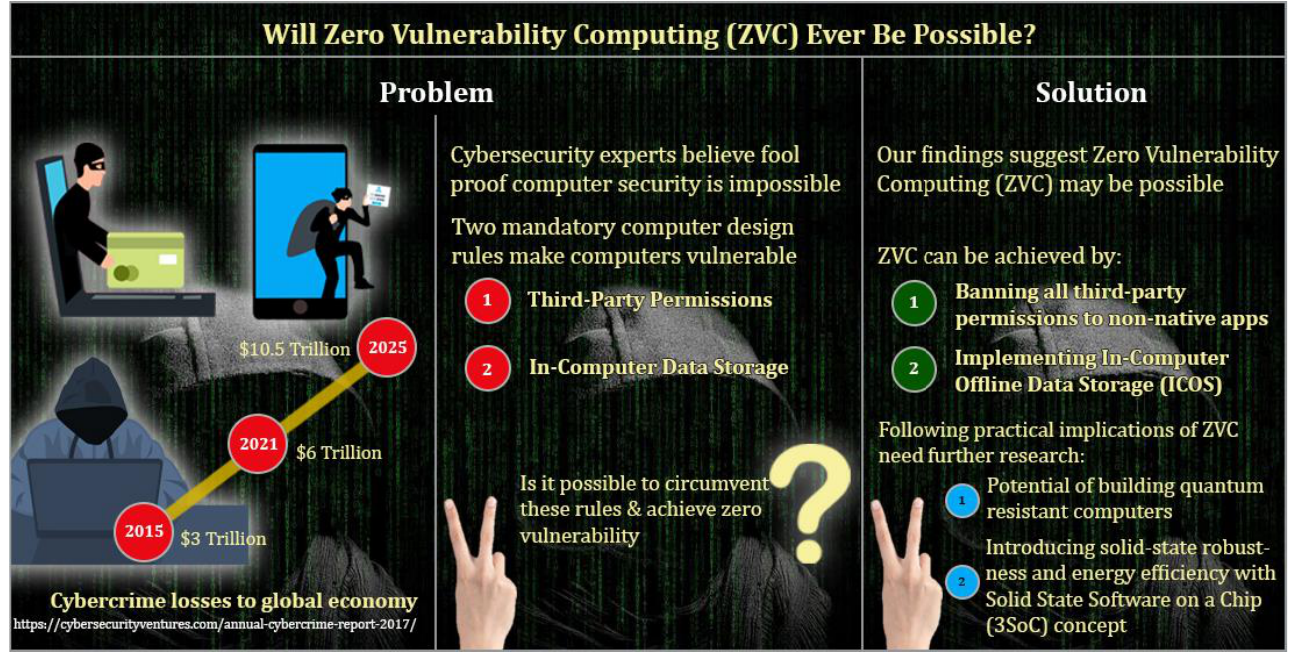
Figure 3. Zero vulnerability computing (ZVC): A graphical abstract. Data Source: Raheman et al. [22].